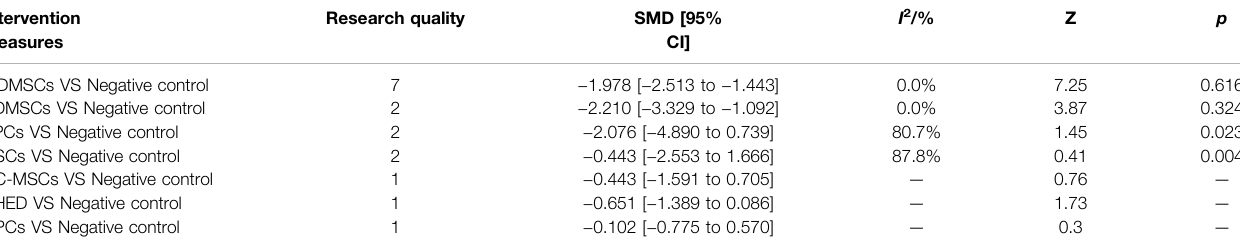
TABLE 9 | Traditional Meta-analysis results of blood urea nitrogen level between stem cell groups and the control group at 7 days after administration. Intervention